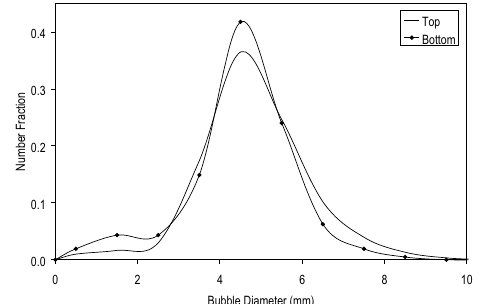
Figure 5. A comparison between bubble size distribution in term of number fraction in bottom and top of column experimentally obtained for butanol solution.